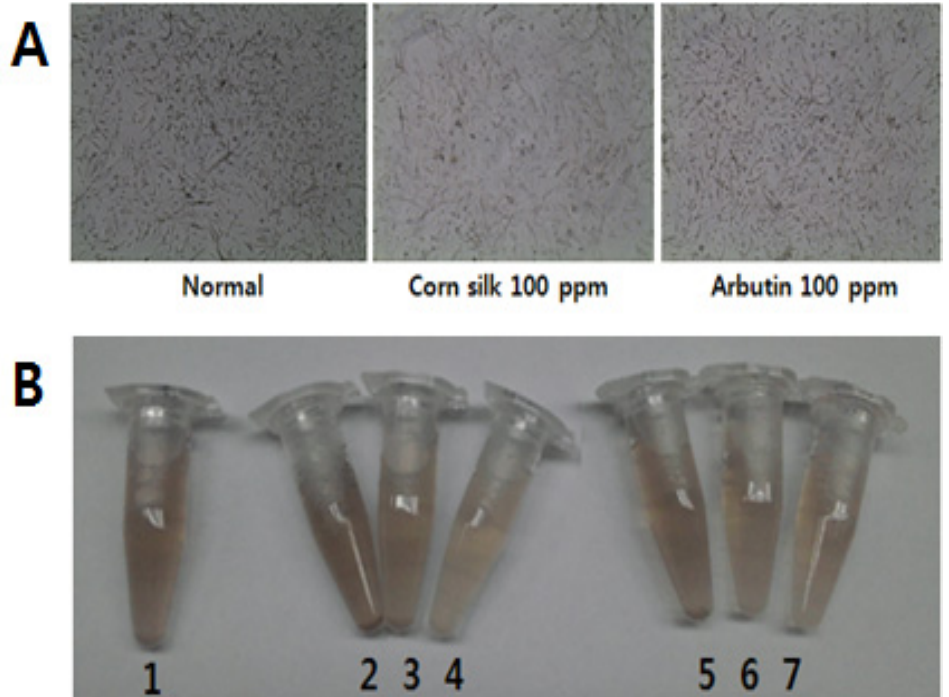
Figure 1. Effects of corn silk extract and arbutin on Melan-A cells. ( A ) Melan-A cell image after 3 days’ corn silk treatment (magnification 200×); ( B ) Effects of corn silk extract on the color of a Melan-A cell pellet.